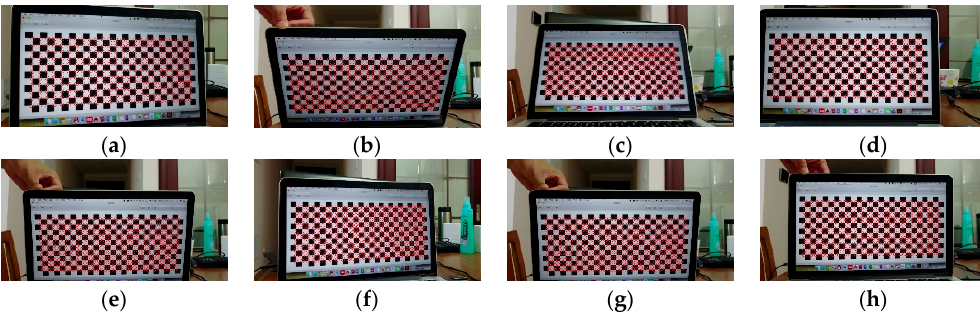
Figure 6. Eight views of the 2D chessboard exhibited as examples. ( a − h ) are the eight views of the 2D chessboard. Red circles with a center denote the referenced corners.